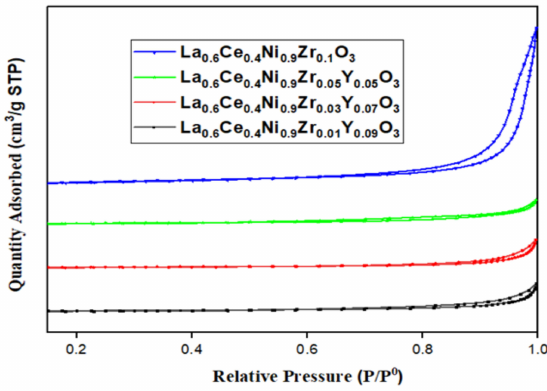
Figure 2. Nitrogen physisoption isotherms of catalyst La 0.6 Ce 0.4 Ni 0.9 Zr 0.1 − x Y x O 3 (x = 0.05, 0.07, and